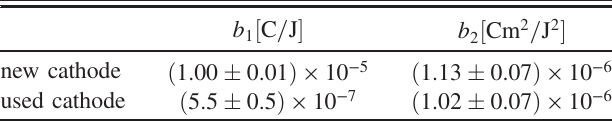
TABLE II. Photoemission coefficients for the new and used